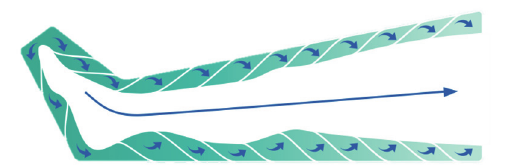
Figure 1. Schematic illustration of an inflatable leg sleeve including 12 circular air chambers. Each chamber is inflated individually to compress a section of the leg. The pressures in the individual chambers form a gradient along the leg. The highest pressure (dark green) is applied to the foot. Through external compression of the leg, a part of the peripheral blood is shifted towards the upper body.